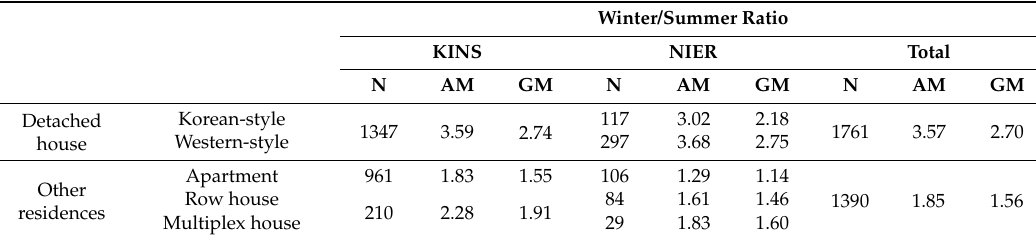
Table 2. Winter/summer ratios of indoor radon concentrations in different types of